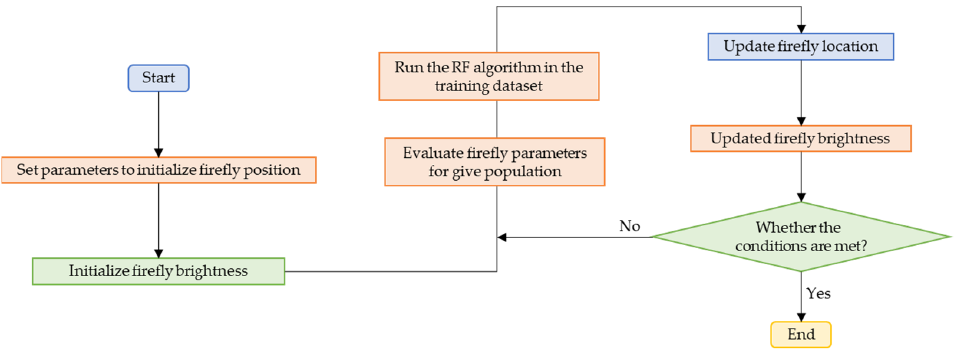
Figure 3. Flow chart of the hybrid model.